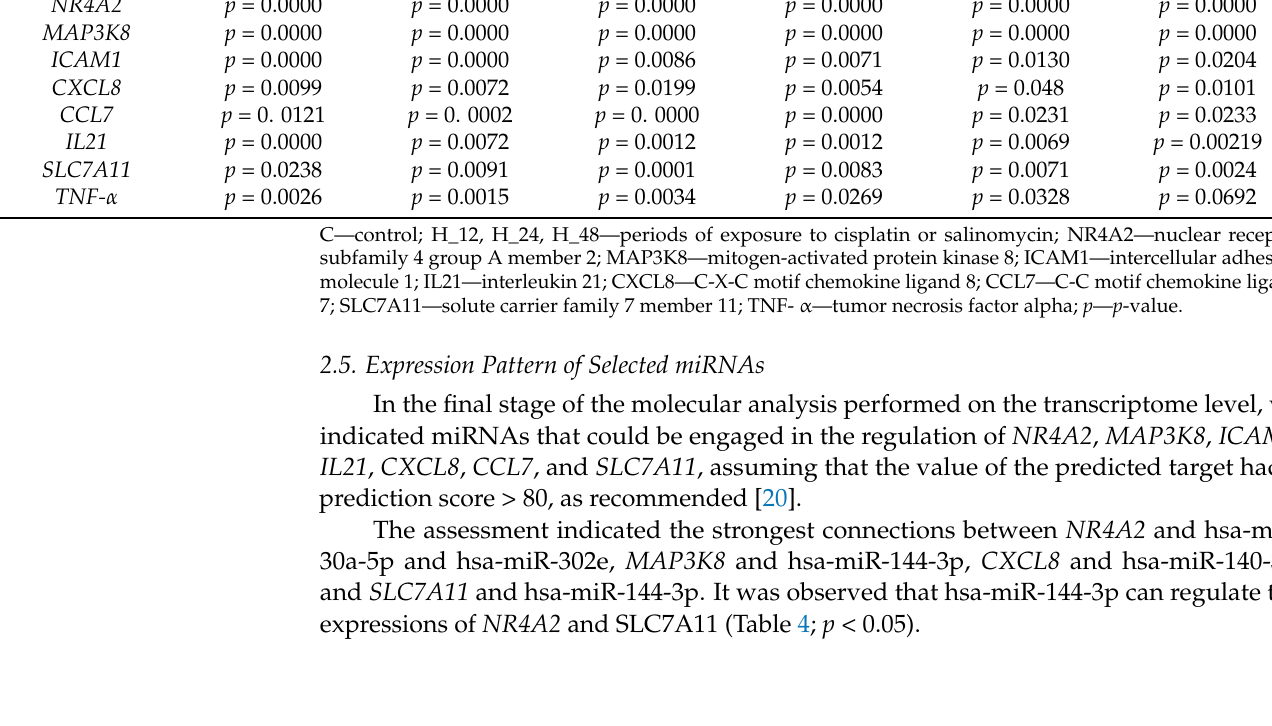
Table 3. Results of the one-way ANOVA and post hoc Tukey’s test on RTqPCR